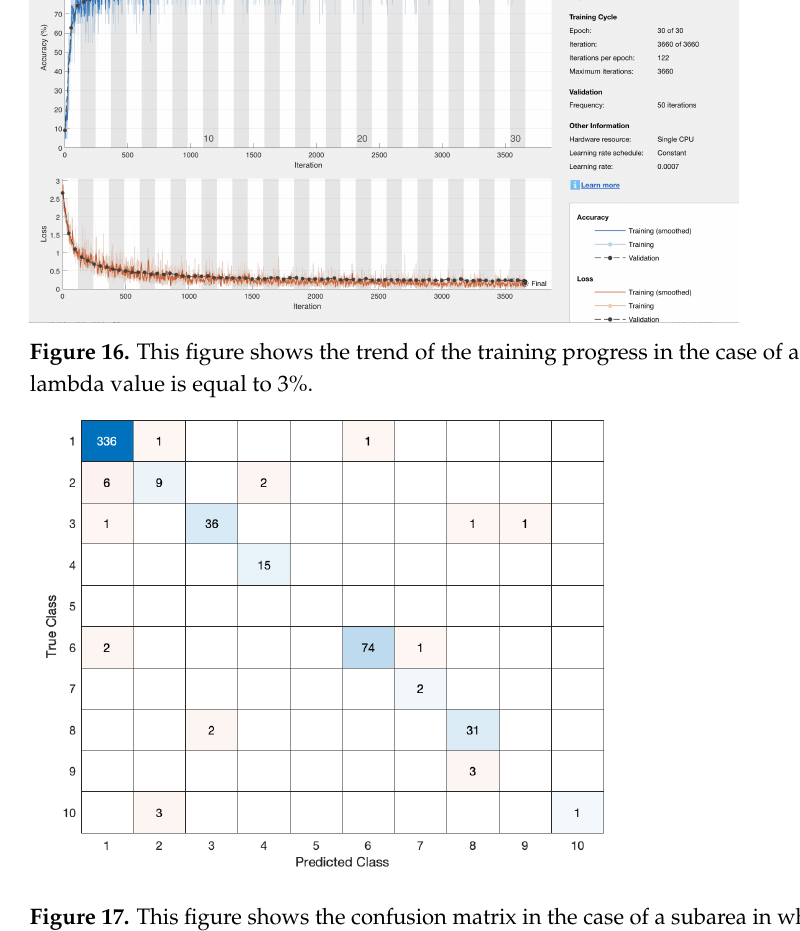
Figure 17. This figure shows the confusion matrix in the case of a subarea in which the lambda value is equal to